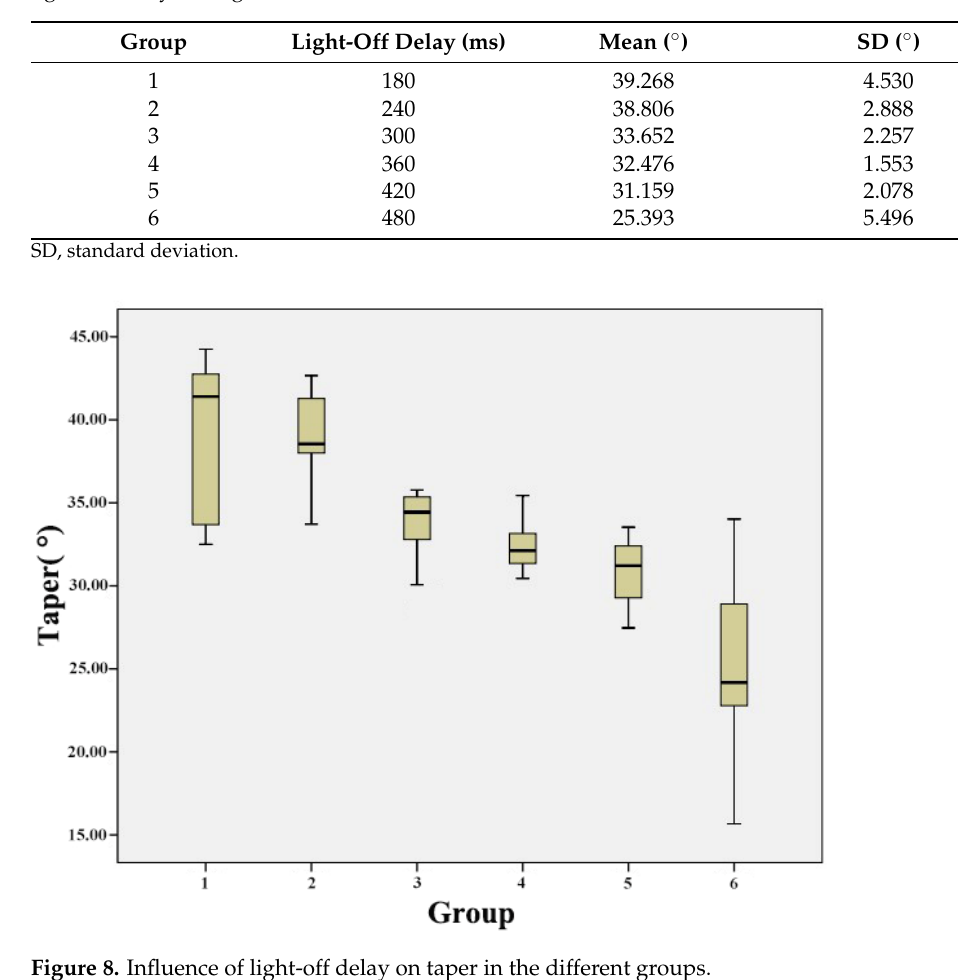
Figure 8. Influence of light-off delay on taper in the different groups. Table 2. Statistical analysis ( p -value) of the taper (in ◦ ) of the tooth preparations made using different light-off delay